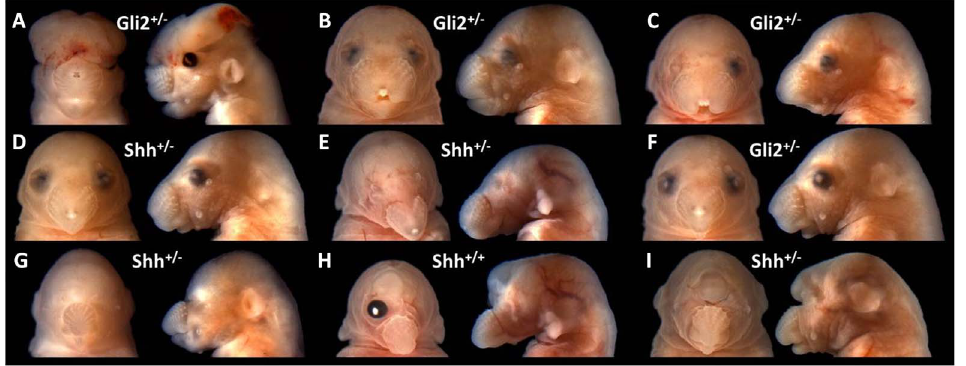
Figure 3. Subpopulation of GD17 fetuses exhibiting severe craniofacial phenotypes. Included in the study population were 9 fetuses with phenotypes not typically observed in wildtype C57BL/6J mice exposed to the employed ethanol exposure paradigm (A-I). Single allele mutations in Shh or Gli2 were detected in 8 of 9 fetuses in this severely affected subpopulation. In addition to varying degrees of upper midfacial deficiency, other notable defects included exencephaly (A), iridial coloboma and microphthalmia (A-D), apparent anophthalmia (E, G, I), agnathia (E), micrognathia (A- D, F-I), and proboscis (I). Median cleft lip was also observed (B, C). Within this subpopulation, fetuses were assigned dysmorphology scores as follows: 2 (A), 3 (B-F), 4